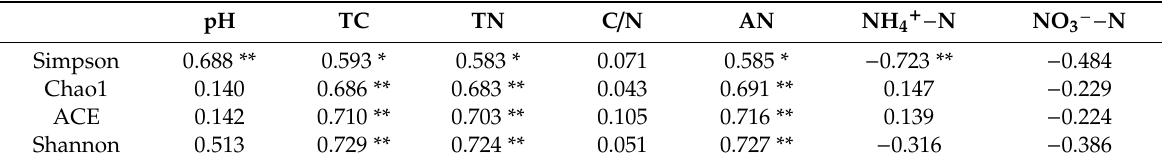
Table 4. Pearson correlations between soil bacterial diversity indices and available edaphic